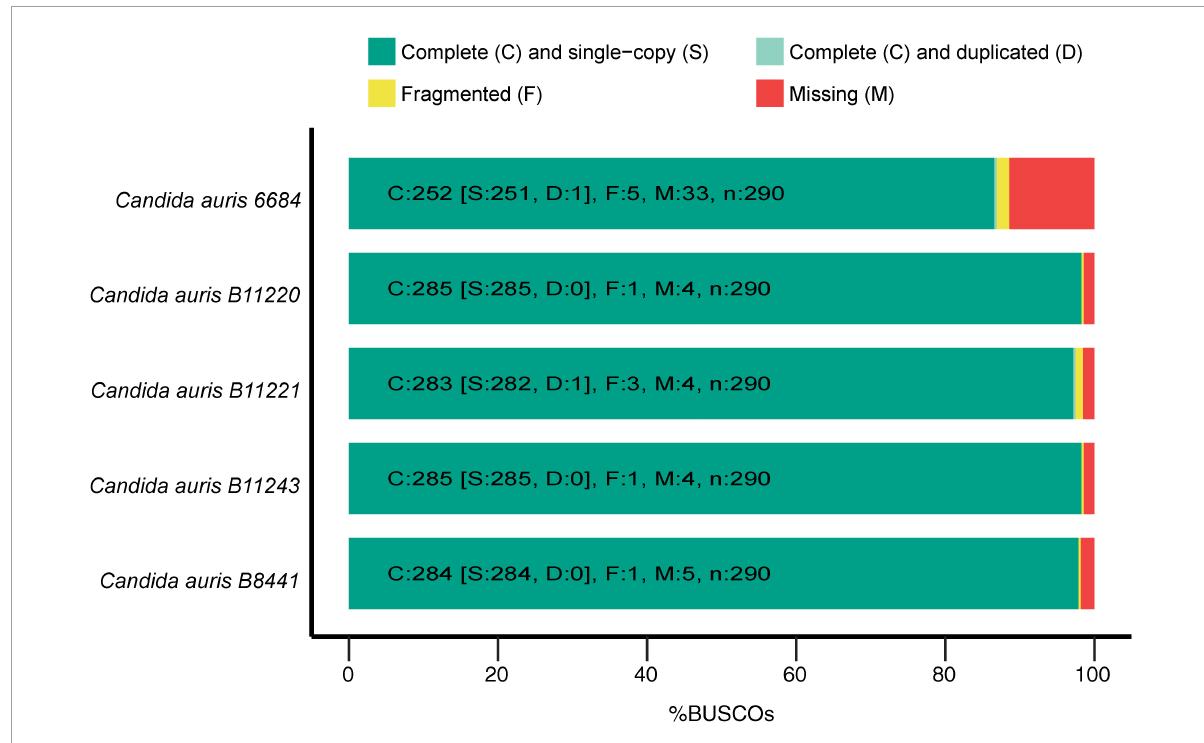
FIGURE1 Genome statistics. The graph depicts the genome completeness of the investigated Candida auris strains as determined by benchmarking universal single-copy orthologs (BUSCO), with BUSCOs for Fungi (odb9) serving as the